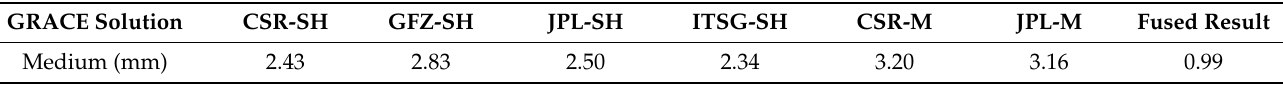
Table 1. Uncertainties of the TWSC results derived from the six GRACE solutions and fused results estimated by the GTCH